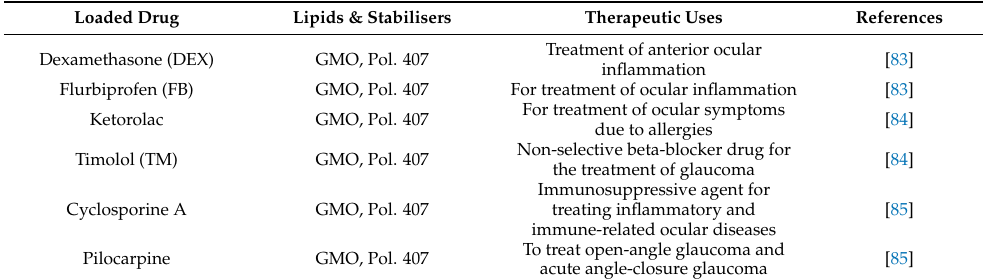
Table 8. Applications of cubosomes as ocular drug delivery system.